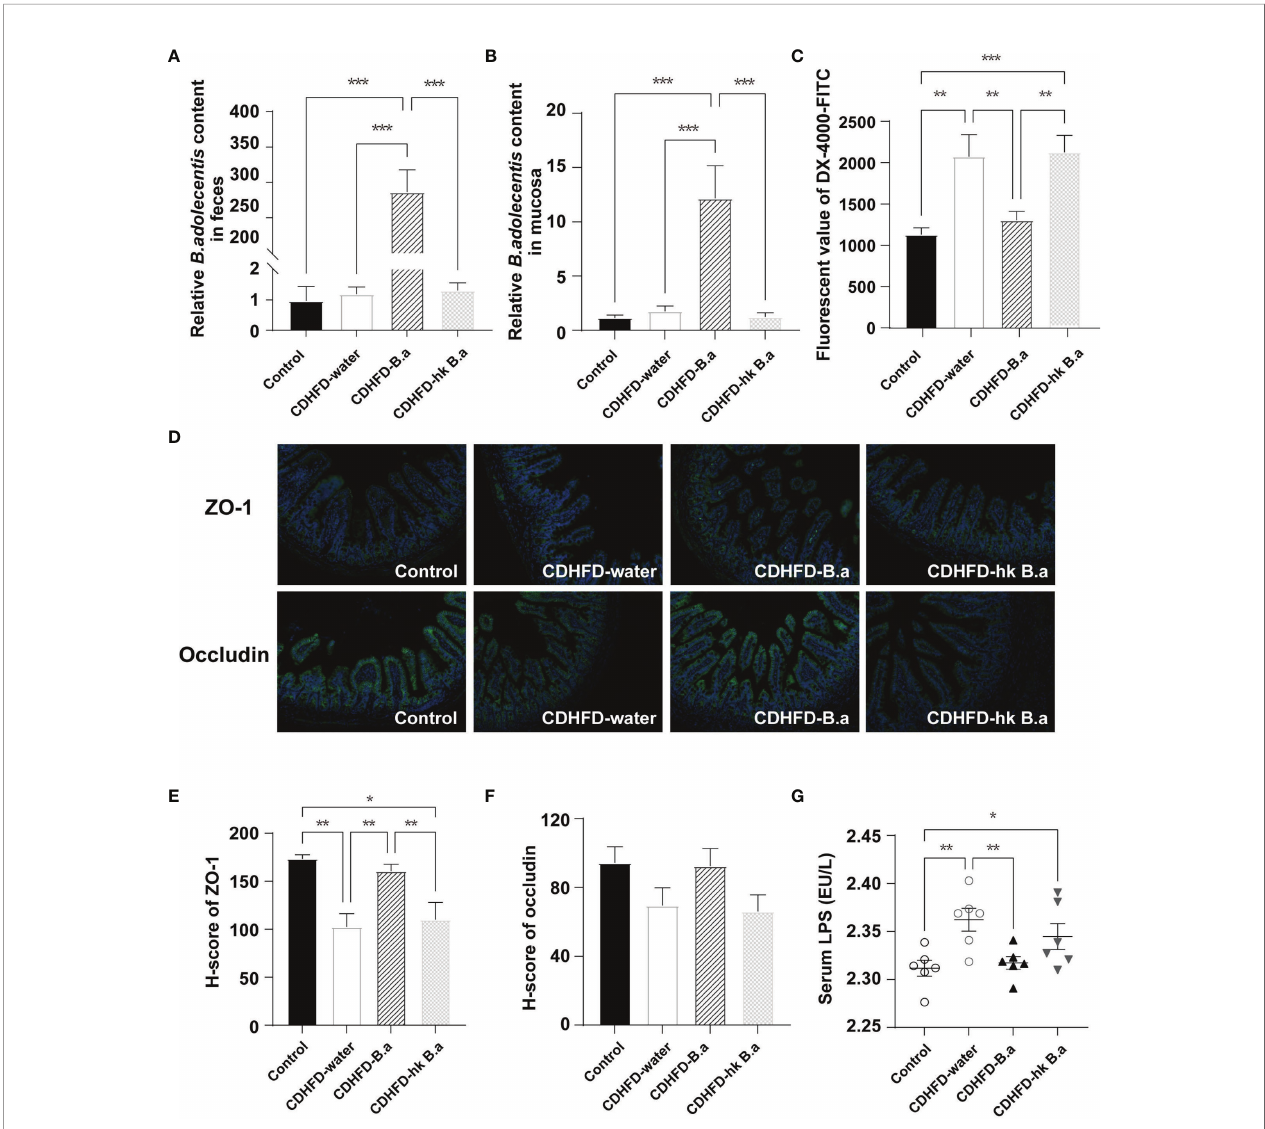
FIGURE 2 | Effect of B. adolescentis on intestinal permeability. Mice were grouped and treated as in Figure 1 . (A, B) Abundance of B.adolescentis in feces and mucosa after intervention determined by qPCR (n = 6 in each group). (C) Serum concentrations of DX-4000-FITC at 1 hour after oral gavage (n = 6 in each group). (D) ZO-1and occludin and in ileum detected by immuno fl uorescent staining. (E, F) H-score of ZO-1 and occludin measured in ileum section with immuno fl uorescent staining. (G) The level of serum LPS (n = 6 in each group). DX-4000-FITC, fl uorescent-labeled dextran; H-score, histochemistry score; LPS, lipopolysaccharide; ZO-1, zonula occludens-1. Data are presented as mean ± SEM. Signi fi cance was determined by one-way ANOVA with Fisher ’ s LSD multiple-comparison analysis. *p < 0.05; **p < 0.01; ***p <